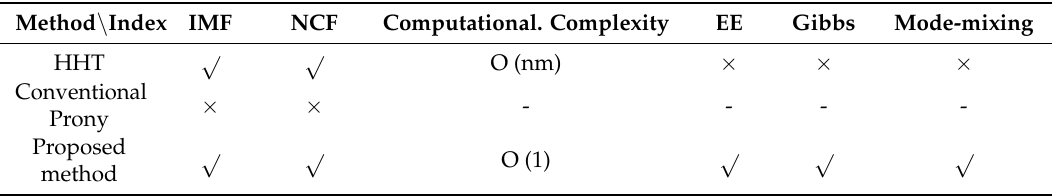
Table 6. Comparison of the Proposed and Other Related